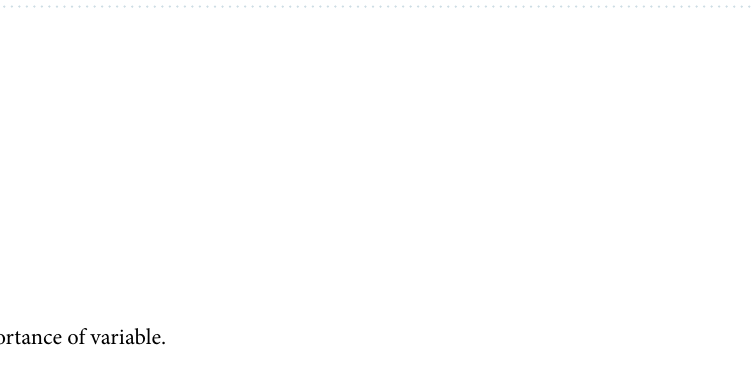
Figure 8. Python code for importance evaluation calculations.